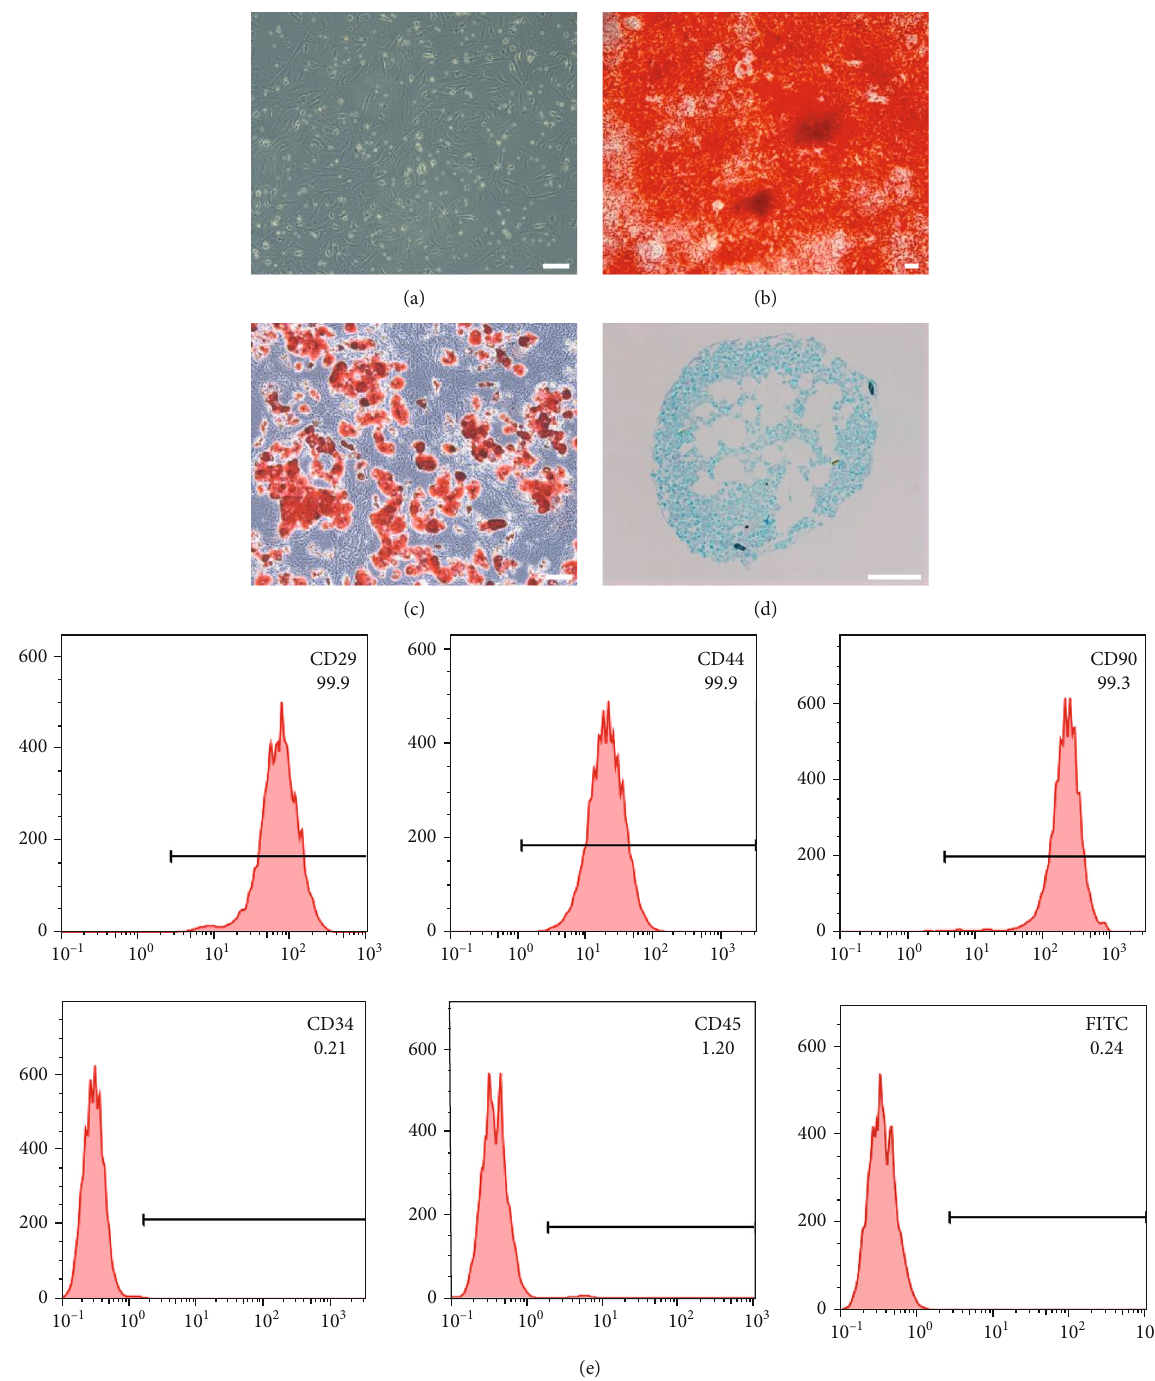
Figure 1: Characterization of rBMSCs. (a) Primary culture of rBMSCs. (b – d) Multiple di ff erentiation ability of rBMSCs. Cells were treated with osteogenic induction medium for 14 days and stained with (b) Alizarin Red. Cells were treated with adipogenic induction medium for 14 days and stained with (c) Oil Red “ O. ” Cells were treated with chondrogenic induction medium for 21 days and stained with (d) Alcian blue. (e) Flow cytometry analysis of surface markers of rBMSCs. rBMSCs were positive for mesenchymal stem cell markers (CD29, CD44, and CD90), but negative for hematopoietic cell markers (CD34 and CD45). The FITC-conjugated mouse IgG isotype was used as a negative control. Scale bar, 100 μ